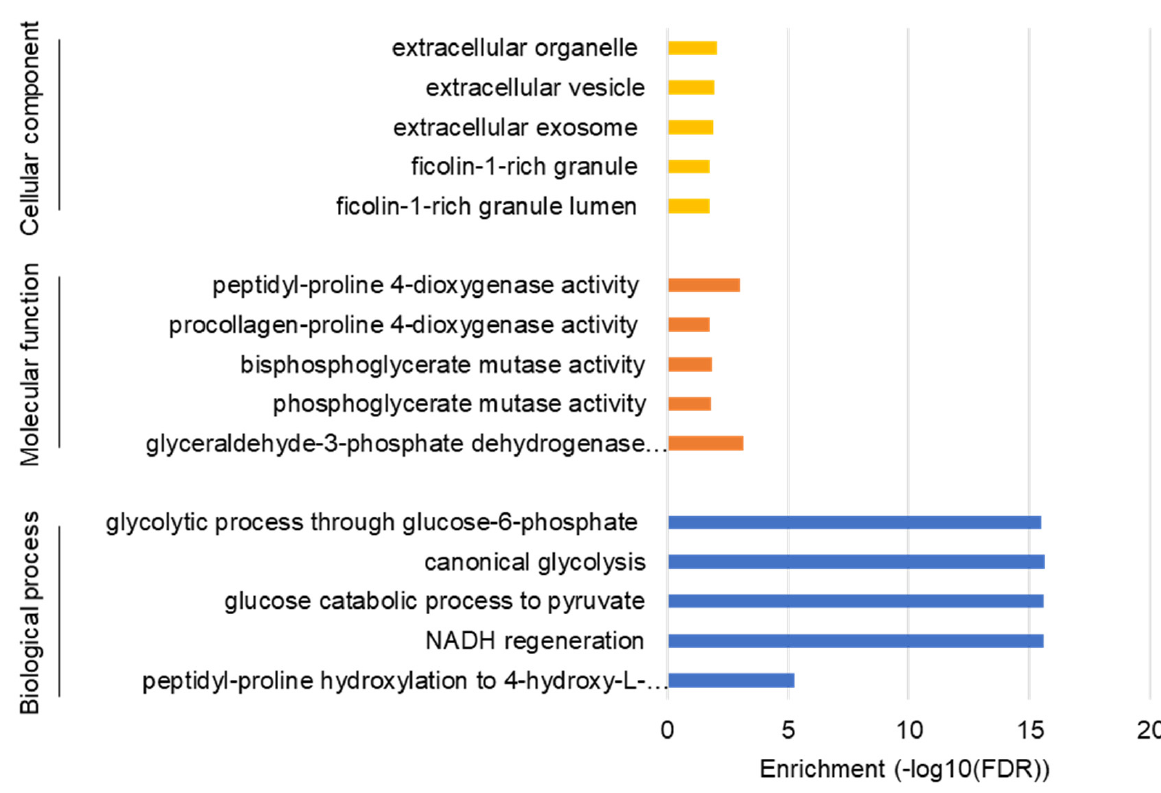
Figure 2. GO enrichment analysis for biological process, molecular function, and cellular components. The false discovery rate (FDR) values on a minus log10 scale were used for enrichment meas- urement.